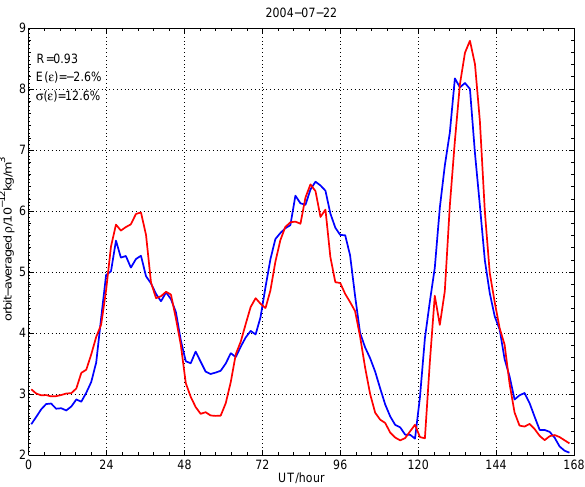
Fig. 8. The same format as in Fig. 7, but for the orbit-averaged density prediction in 22–28 July